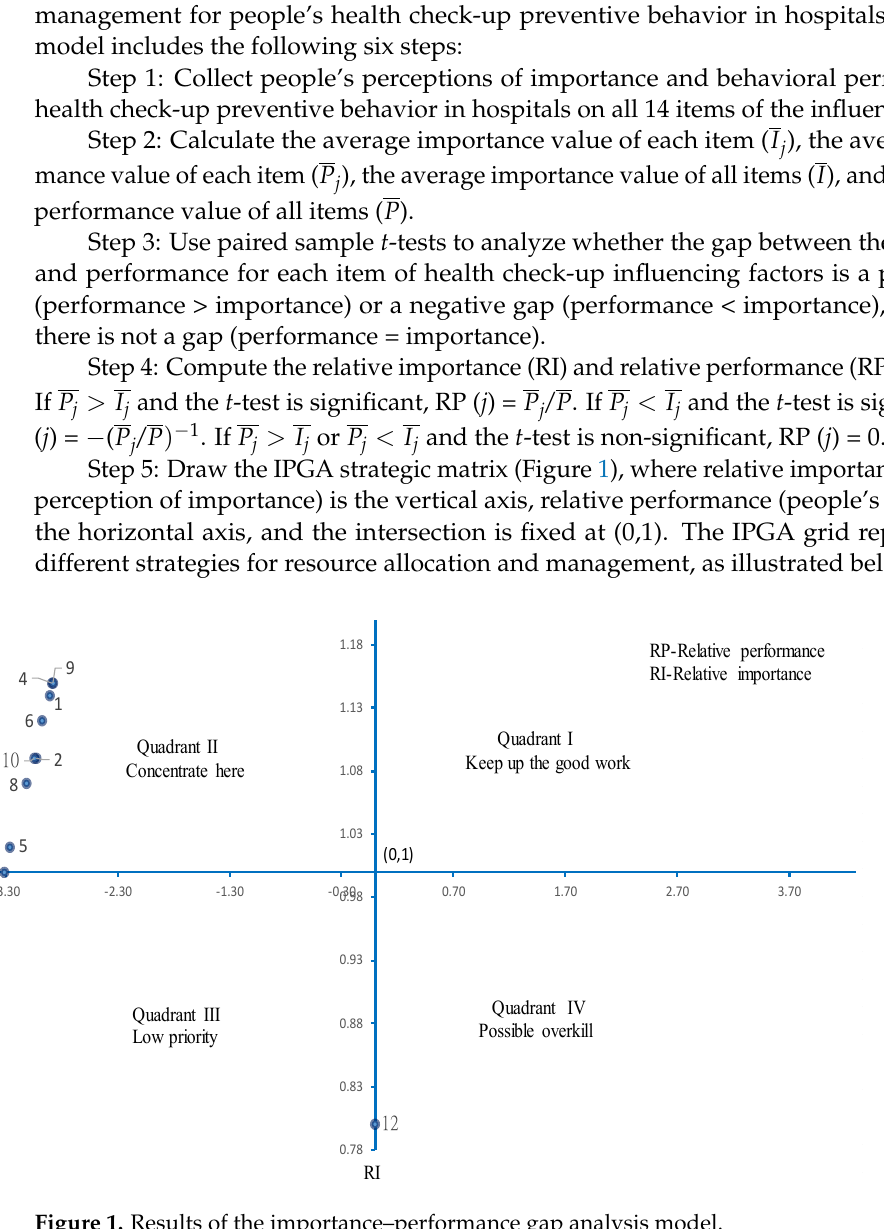
Figure 1. Results of the importance–performance gap analysis model. (1) Quadrant I is composed of a high relative performance and a high relative im- portance and corresponds to “Keep up the good work”. (2) Quadrant II is composed of a low relative performance and a high relative importance and corresponds to “Concentrate here”. A point further away from coordinate (0,1) indicates a greater need for improvement. (3) Quadrant III is composed of a low relative performance and a low relative importance and corresponds to “Low priority”. (4) Quadrant IV is composed of a high relative performance and a low relative importance and corresponds to “Possible overkill”. A point further away from coordinate (0,1) indicates a greater need to re-allocate resources. Step 6: Determine the priorities for resource allocation for the items in Quadrant II. The distance D( j ) indicates the priority for